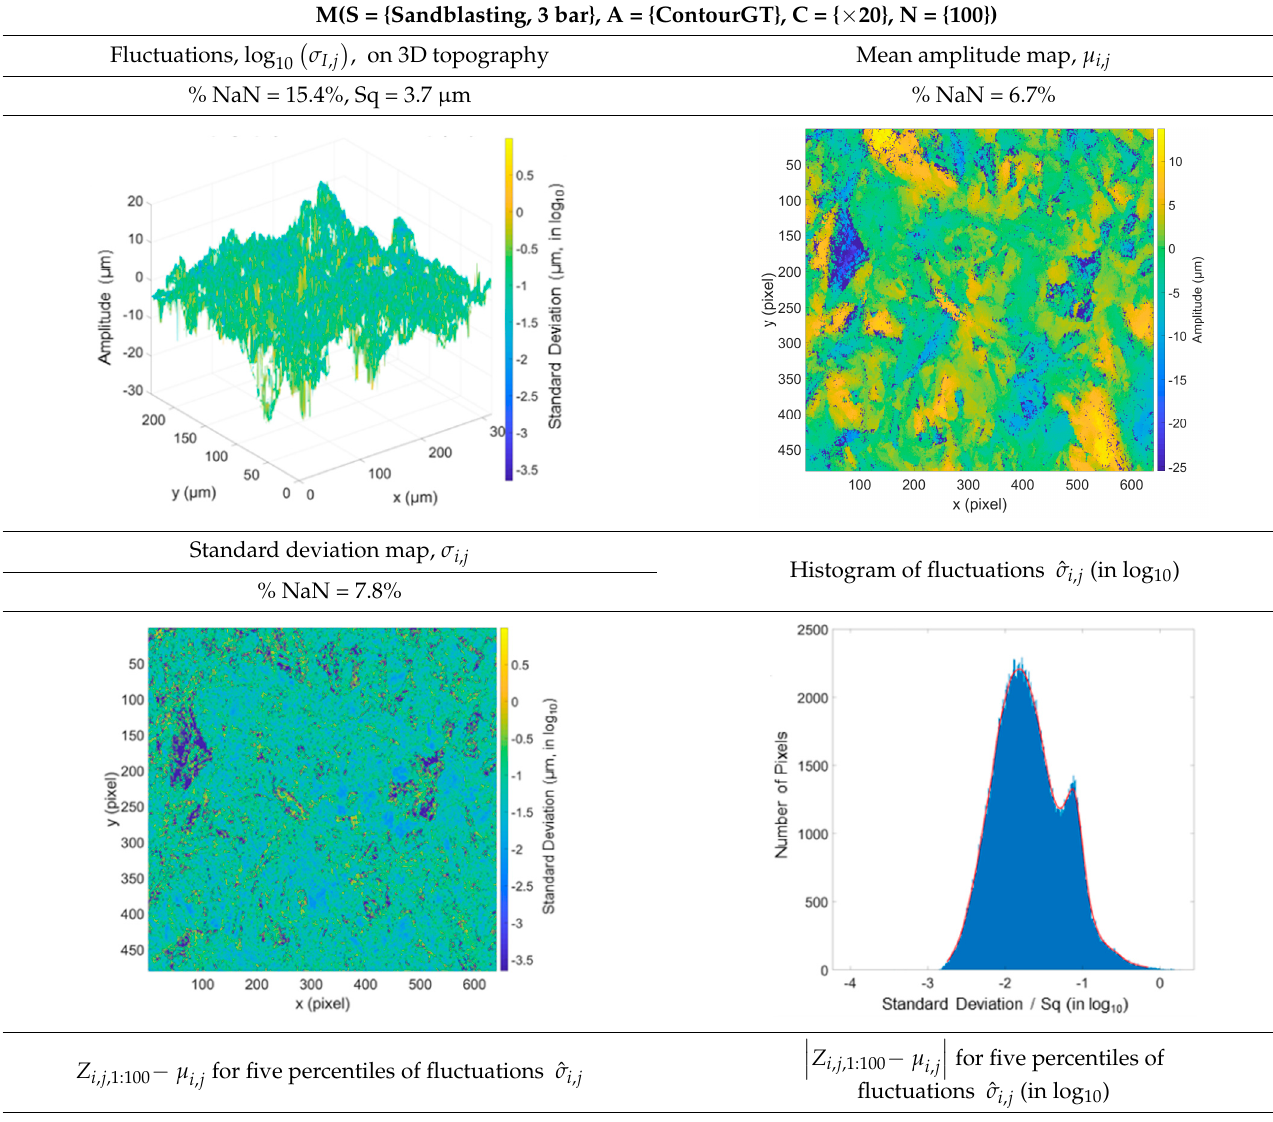
Table A1. Sandblasted Surface, 3 Bars.